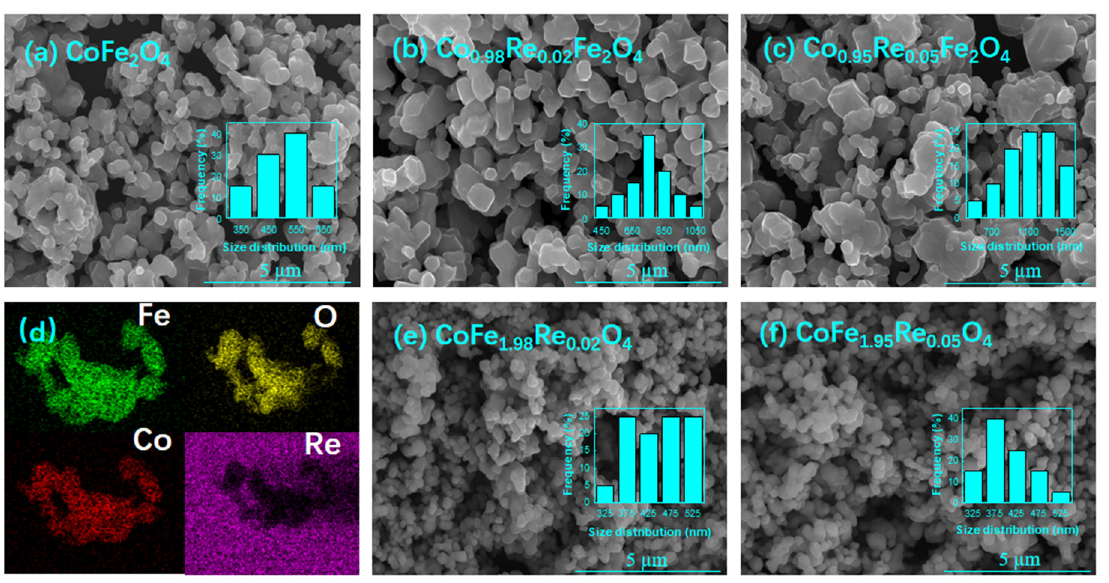
Figure 3. SEM image of ( a ) CoFe 2 O 4 , ( b ) Co 1 . 98 Re 0 . 02 Fe 2 O 4 , and ( c ) Co 1 . 95 Re 0 . 05 Fe 2 O 4 ; ( d ) EDS mapping of Fe, O, Co, and Re elements for the Co 1 . 98 Re 0 . 02 Fe 2 O 4 nanoparticle, showing a uniform distribution of the elements. SEM image of ( e ) CoFe 1 . 98 Re 0 . 02 O 4 and ( f ) CoFe 1 . 95 Re 0 . 05 O 4 nanoparticles. Agglomeration appeared for all doped samples. However, the agglomeration is severely reduced for Fe-site doped samples ( e , f ).